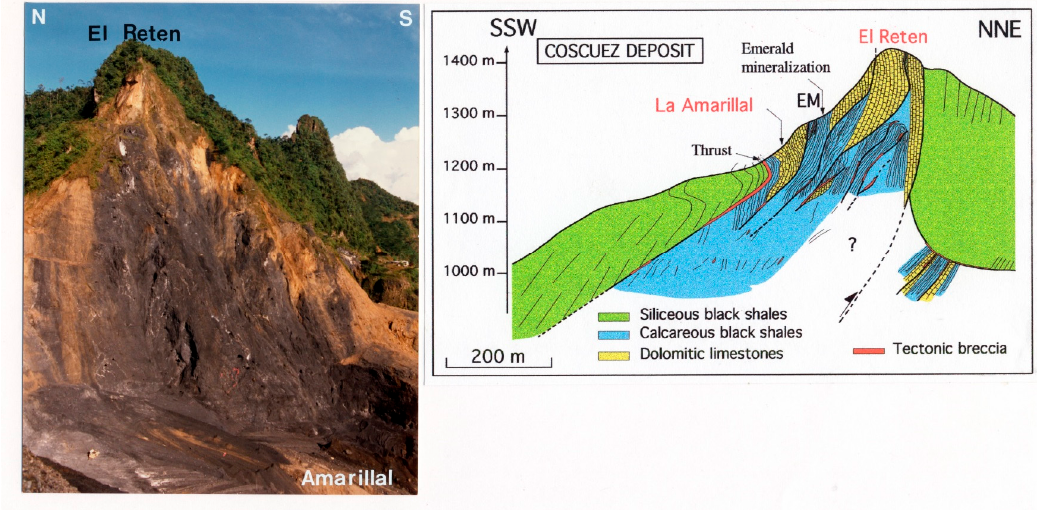
Figure 30. Tectonic style and lithologies of the Coscuez emerald mining district, western emerald zone: ( a ) General view of the Coscuez deposit in 1996. Photograph: Gaston Giuliani; ( b ) geological cross-section of the Coscuez deposit showing the lithostratigraphic column of the formations and the tectonic style marked by thrusts and faults. The emerald mineralization is linked to tectonic hydrothermal breccia zones, faults, thrusts, and stockwork veins